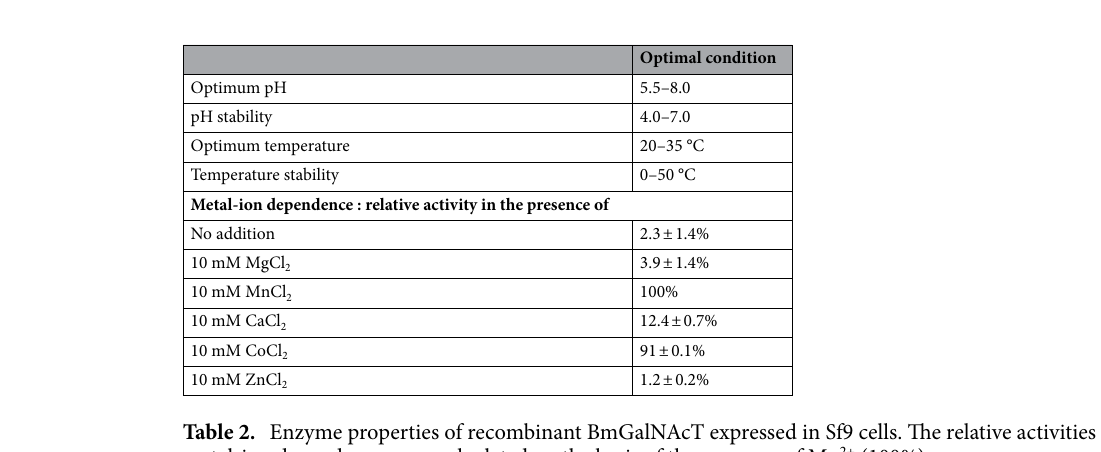
Table 1. Acceptor substrate specificities of the recombinant BmGalNAcT. Relative rates were calculated on the basis of the activity toward GNM3A (100%).